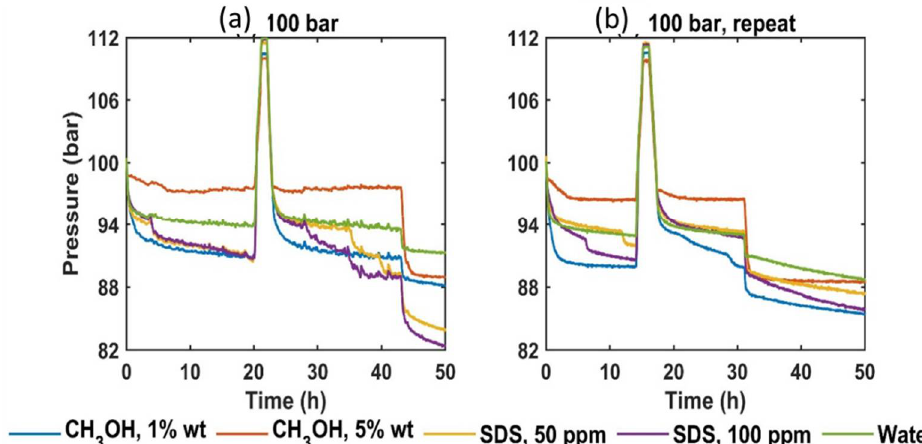
Figure 12. Pressure variation for CO 2 /N 2 gas mixture using 20 mol% CO 2 during the isothermal scheme in the presence of MeOH (1, 5 wt.%) and SDS (1, 5 wt%) at 80 bar. Each temperature cycle runs for more than 14 h. Heating and cooling are done without replacing the sample to study the effect on the used sample. GC samples are collected by cooling down the system at T = − 2 ◦ C. The pressure response curves for 100 bar are shown in the figure ( a , b ). Similar curves are recorded for 120 bar as well. No rapid pressure drop is observed for p = 80 bar when water or additives are present. Pressure increase above initial pressure is on account of temperature increased from 1 ◦ C to 25 ◦ C. (Starting pressure are the pressure at 1 ◦